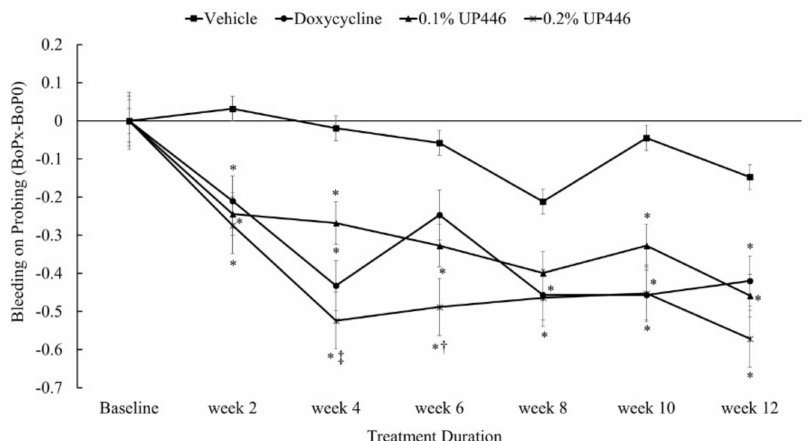
Figure 6. Changes in mean bleeding on probing in beagle dogs with ligature-induced periodontitis. Values are represented as di ff erences between before and after treatment. *; denote significance at p < 0.05 when compared with placebo and treated groups at the same week. † ; denote significance at p < 0.05 when compared with doxycycline and UP446 groups at the same